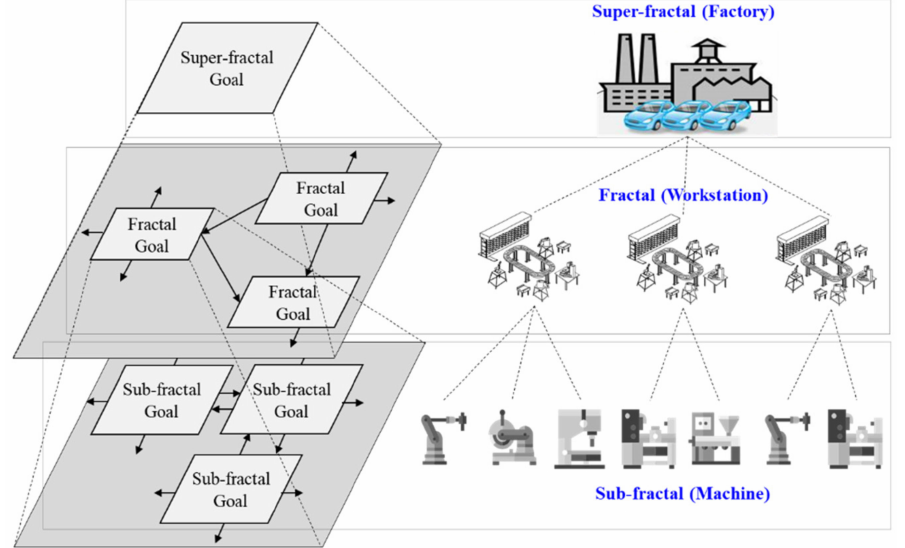
Figure 3. Self-similarity and hierarchical fractal